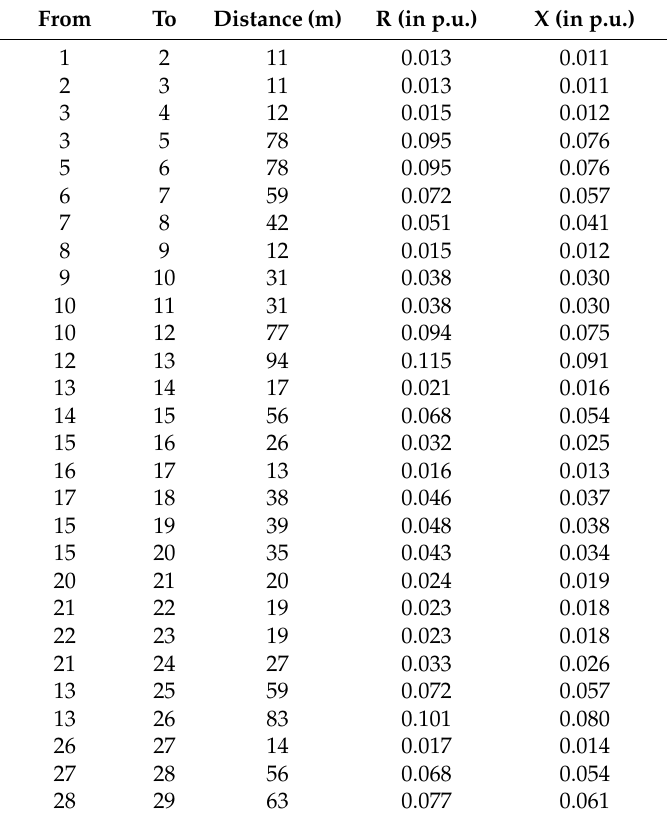
Figure 9. Network structure obtained using simulated annealing. Table 1. Branch data for the Ghotiya village